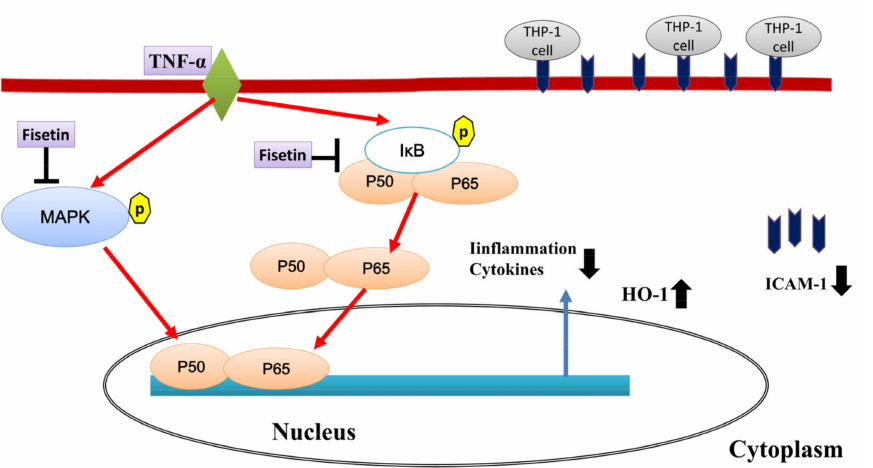
Figure 12. Model explaining the mechanism for the anti-inflammatory and antioxidant effects of fisetin in TNF- α -induced BEAS-2B